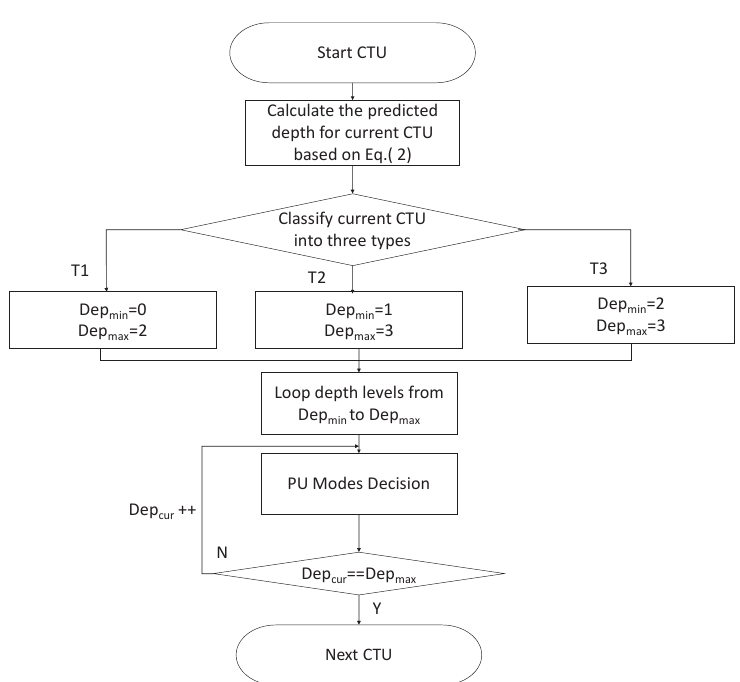
Figure 6. Flowchart of the proposed CTU depth decision.